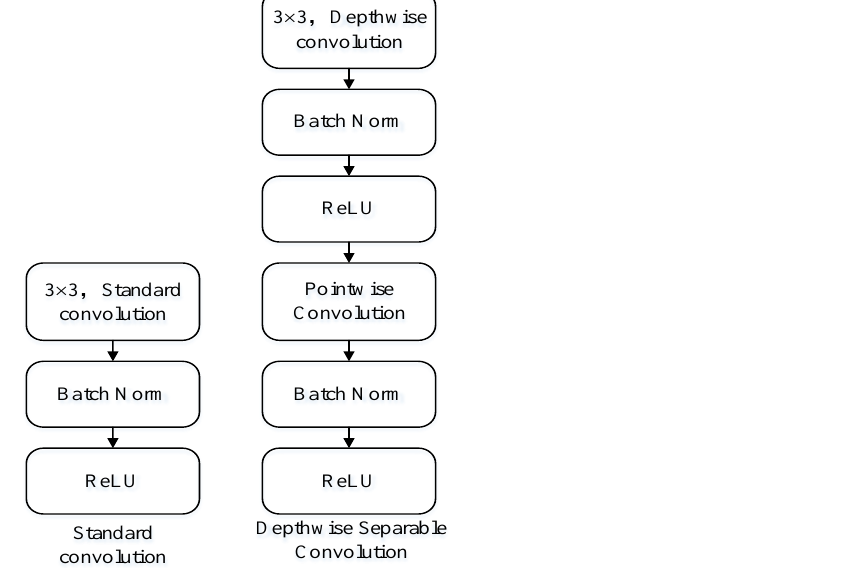
Figure A2. Standard separable convolution and Depth wise separable convolution.